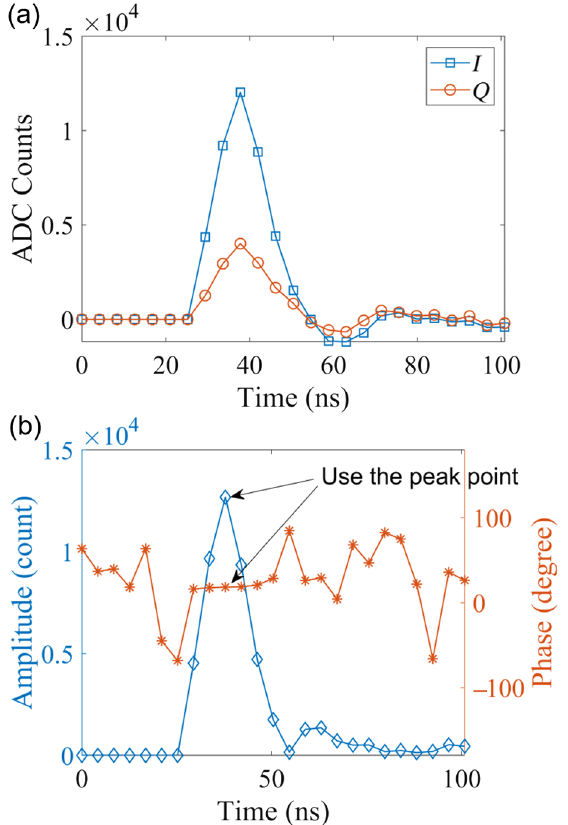
FIG. 14. Charges measured by two BAMs (a). Distribution of residual charge